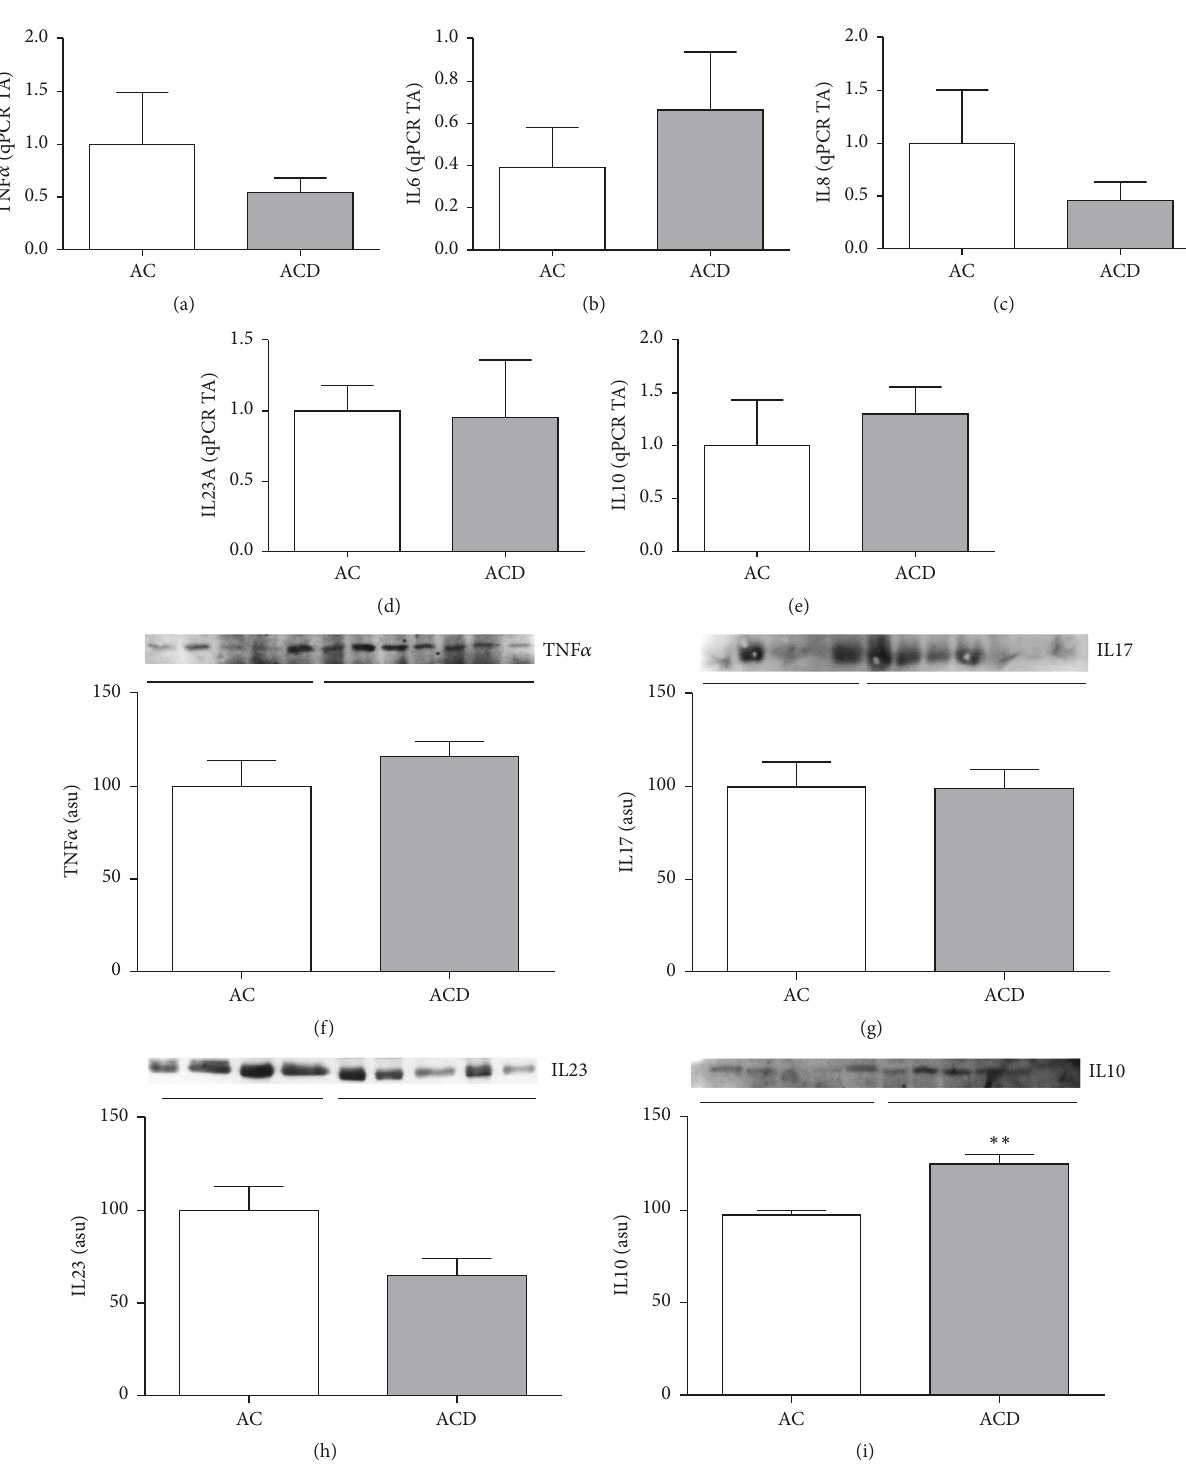
Figure 3: Evaluation of cytokines gene expressions in the mesenteric adipose tissue of Crohn’s disease patients. Inflammatory signaling pattern in the mesenteric adipose tissue of Crohn’s disease patients. mRNA levels (qRT-PCR) of TNF 𝛼 (a), IL6 (b), IL8 (c), IL23A (d), and IL10 (e) in the mesenteric adipose tissue (MAT) of CD patients (ACD Group) compared to controls (AC Group). Western blot analysis of TNF 𝛼 (f), IL17 (g), IL23 (h), and IL10 (i) in the mesenteric adipose tissue (MAT) of CD patients (ACD Group) compared to controls (AC Group). Each band represents one patient. For ACD, 𝑛 = 10 ; for AC, 𝑛 = 8 , ∗ 𝑝 < 0.05 , ∗∗ 𝑝 < 0.01 , and ∗∗∗ 𝑝 < 0.001 versus control. TA: transcription amount. ASU: arbitrary scanning